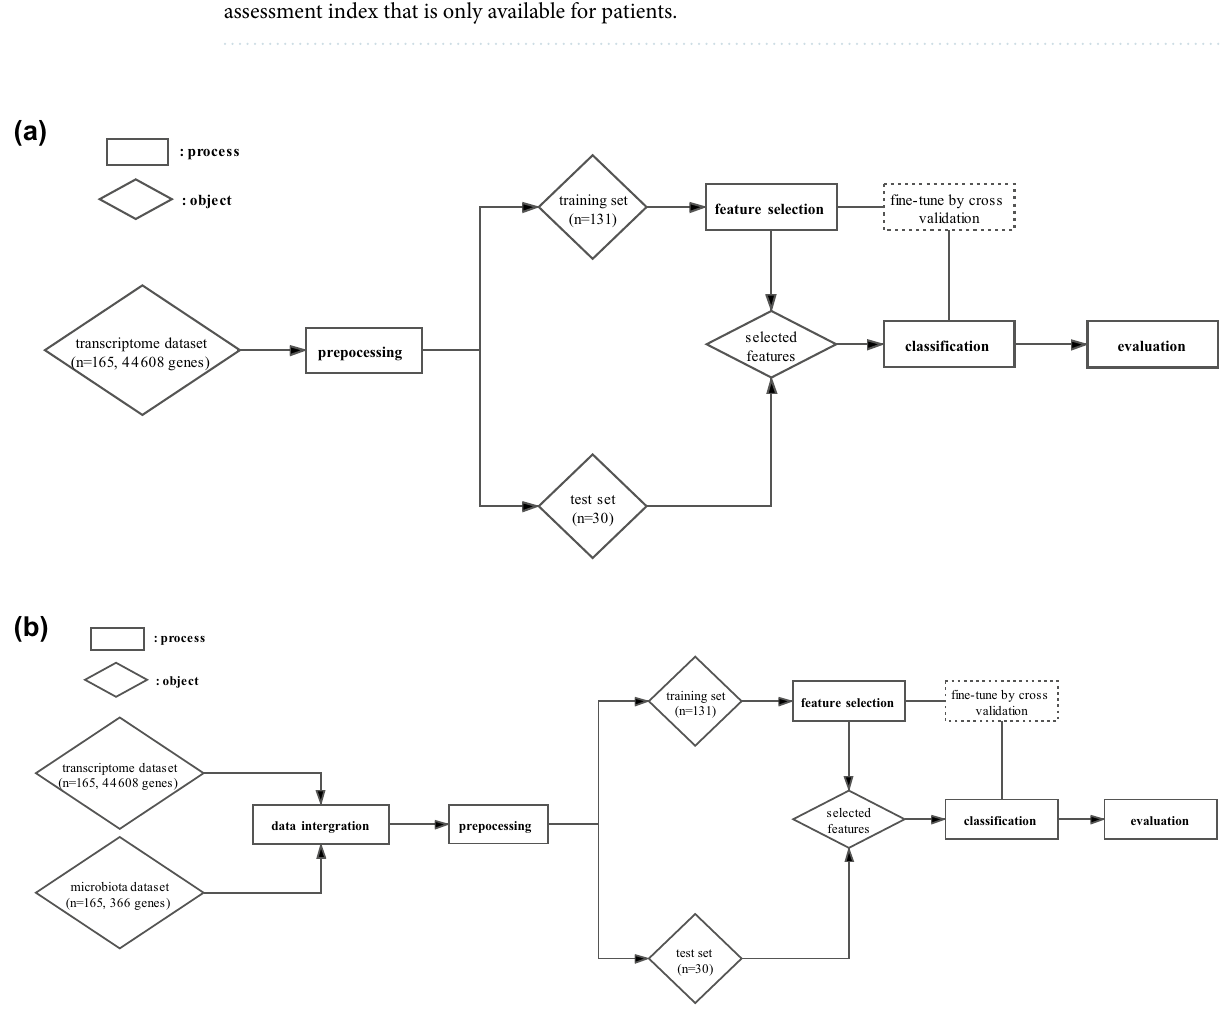
Figure 1. The overview of atopic dermatitis classification pipelines in two settings. ( a ) Transcriptome dataset only, and ( b ) transcriptome and microbiota